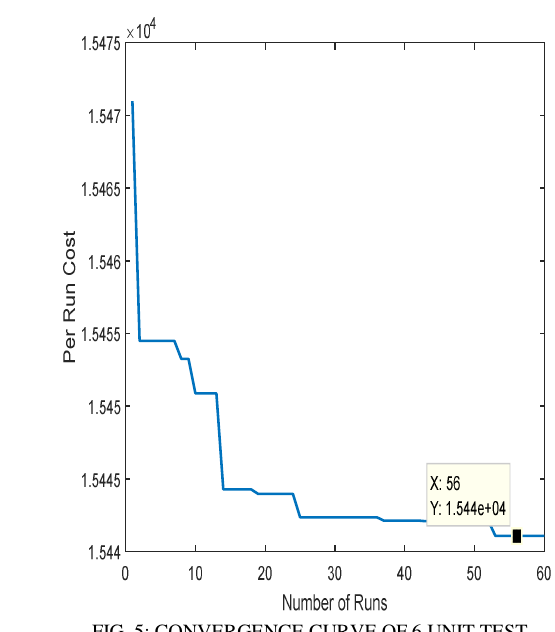
FIG. 5: CONVERGENCE CURVE OF 6 UNIT TEST SYSTEM